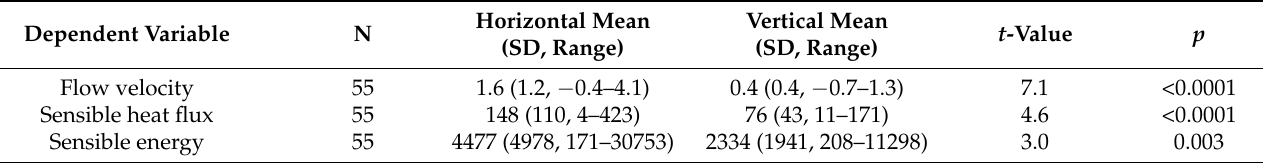
Figure 9. Time series of horizontal and vertical sensible heat flux (rows) across a range in resultant sensible energy (columns). Time series are from the datasets with the lowest ( left ), median ( center ), and highest ( right ) resultant sensible energies (kJ/m 2 ). Table 2. Comparisons between horizontal and vertical flow velocities and sensible heat fluxes averaged over residence times and sensible energies. Overall means and, in parentheses, standard deviations and ranges of average values along with t-test statistics are